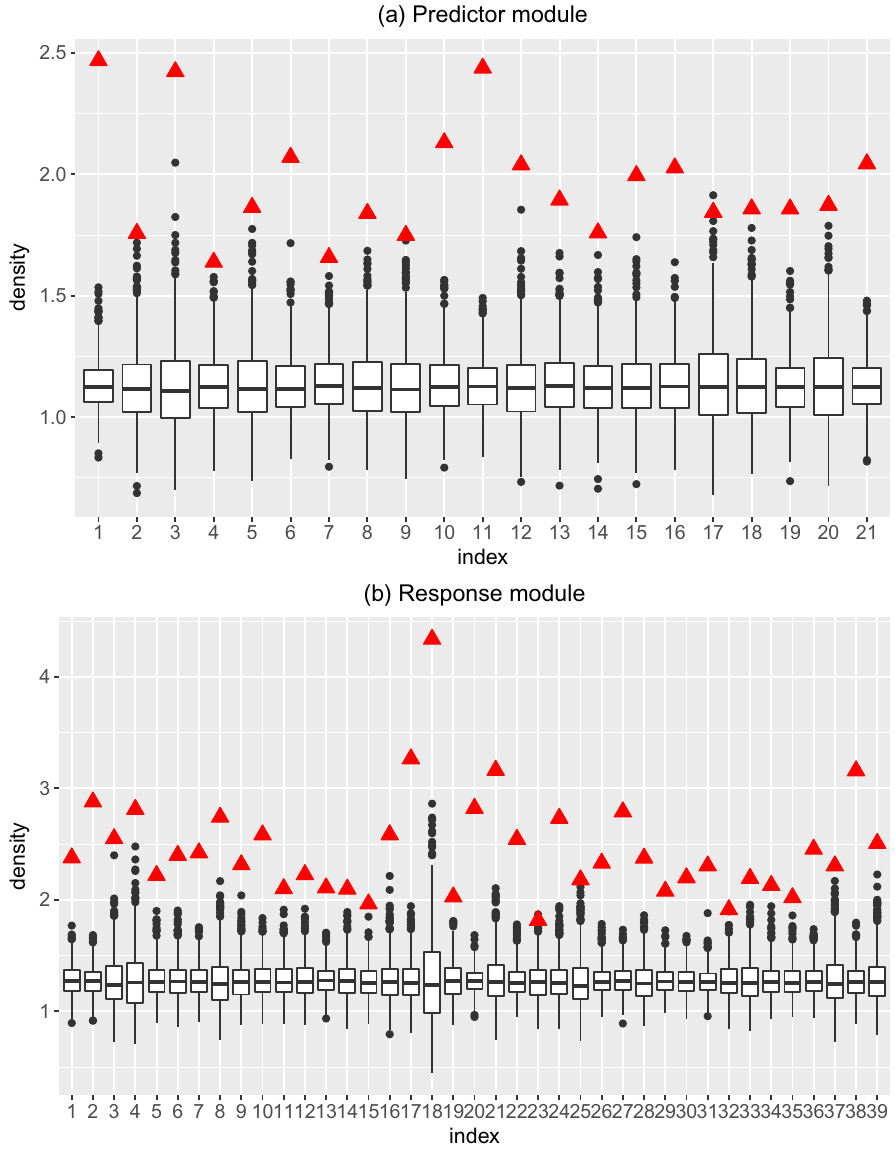
Figure 3. Module density scores. ( a ) The density of identified predictor modules. The red triangles represent observed density scores for predictor modules and boxplots represent the corresponding density scores of 1000 randomly generated modules. ( b ) The density of identified response modules. The red triangles represent observed density scores for response modules and boxplots represent the corresponding density scores of 1000 randomly generated